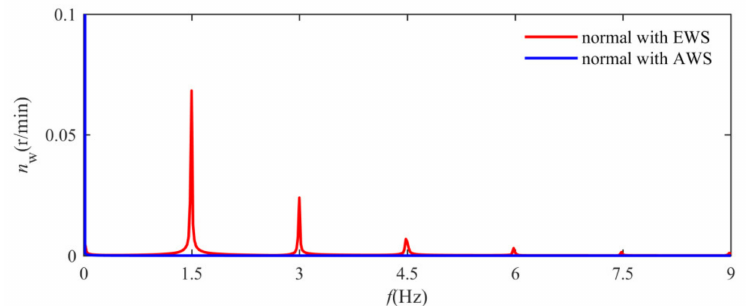
Figure 6. FFT of the WT rotor rotating speed.